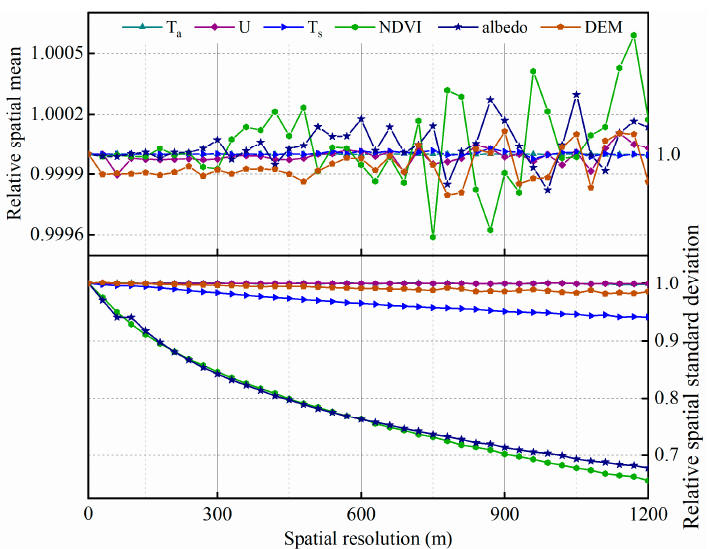
Figure 6. Change of the spatial mean and spatial heterogeneity of the SEBAL input parameters at different spatial resolutions.